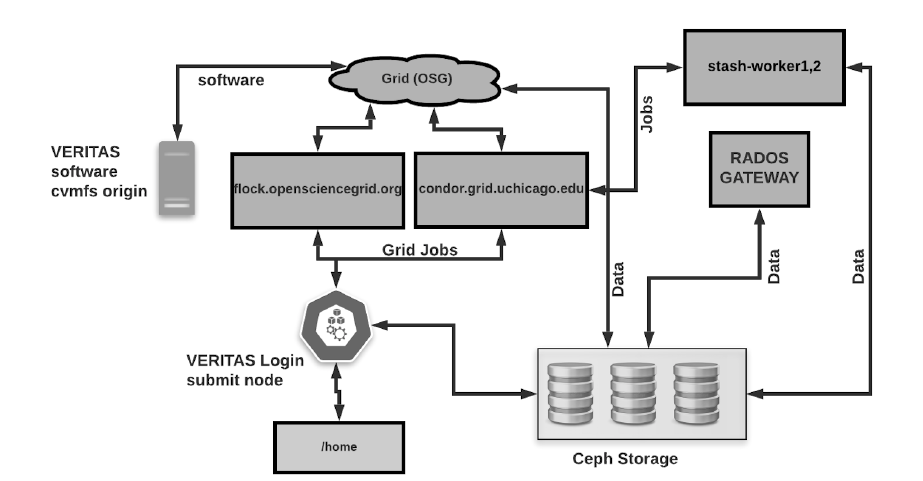
Figure 6. Connect infrastructure deployed at UChicago for the VERITAS